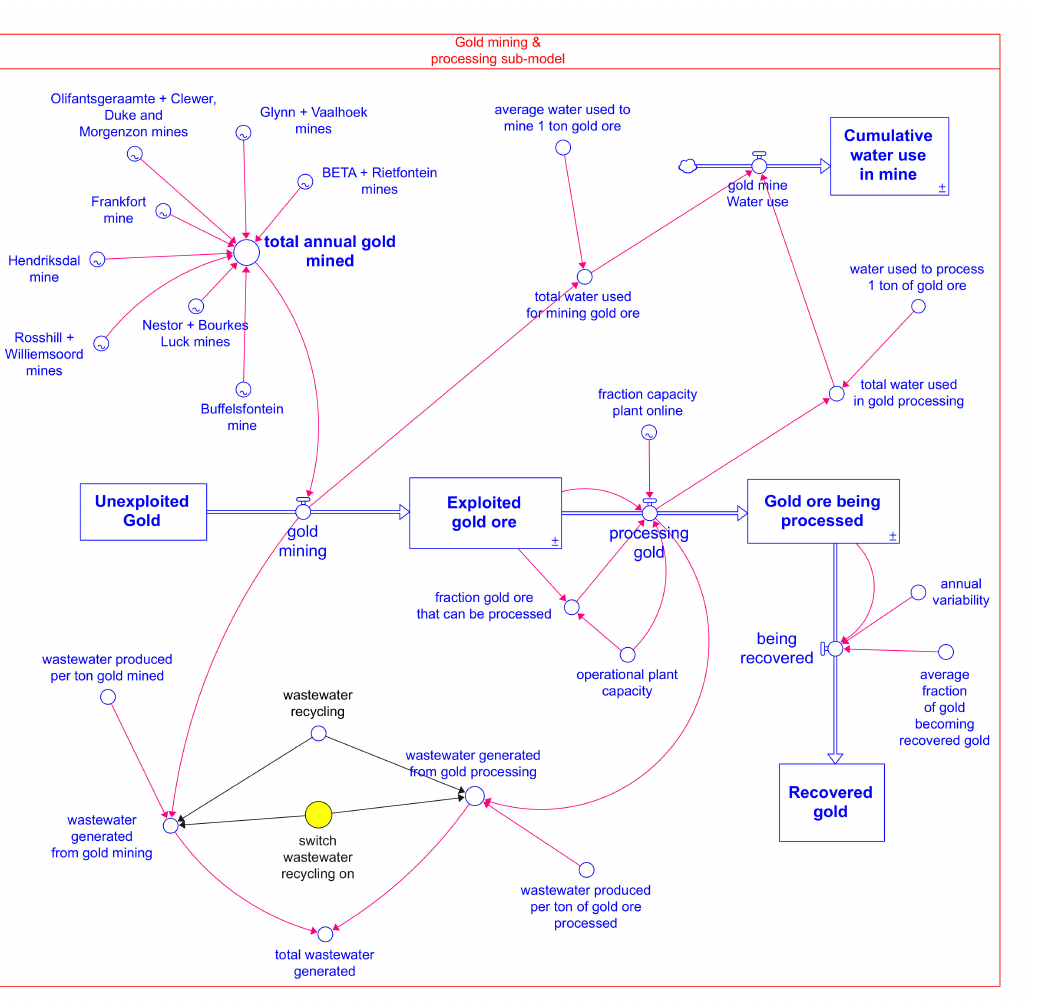
Figure 3. Sub-model 1 represents the gold mining and gold processing sub-model. Variables with the ‘~’ symbol denote either graphical functions or where a LOOKUP data table is behind the